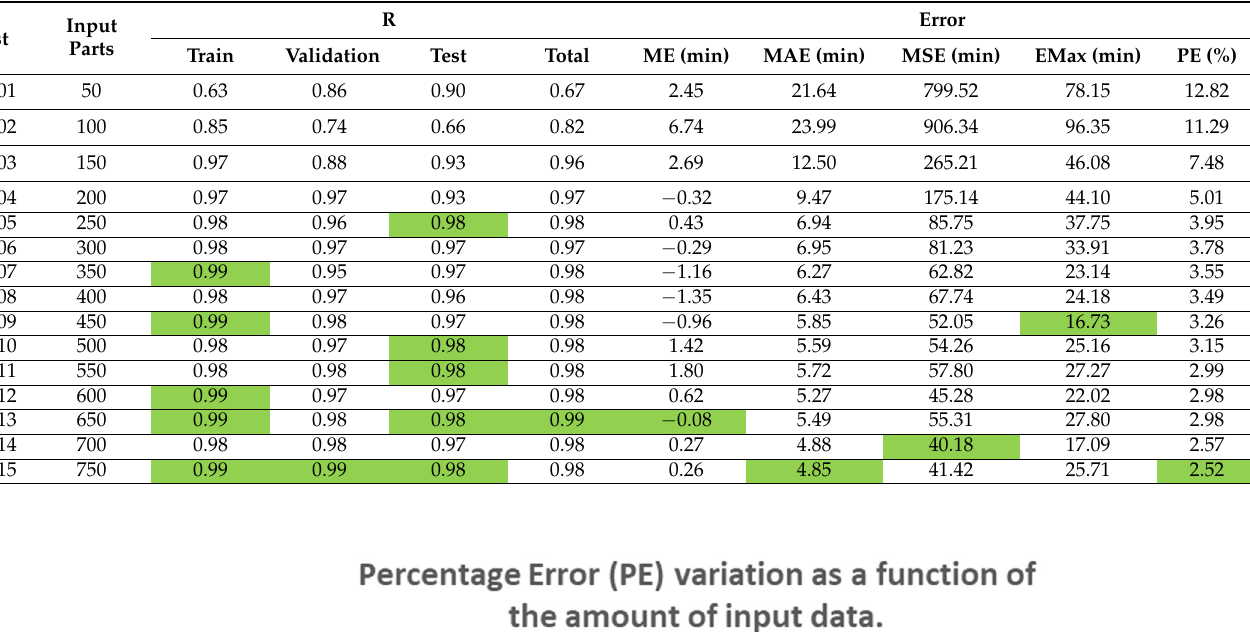
Table 4. Regression and error of the ANNs from Test 2.